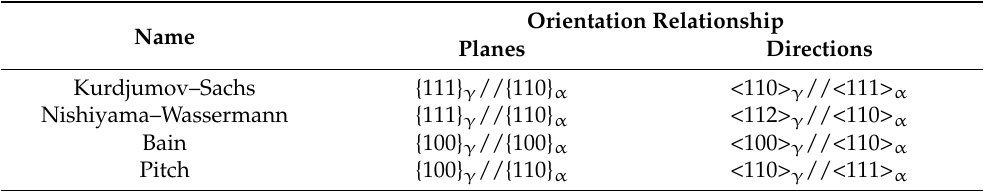
Figure 6. Ferrite variant analysis: ( a ) reconstruction of prior austenite grains; ( b – c ) distribution of deviation angles from K–S, N–W, Bain, and Pitch OR models; ( d ) a prior austenite grain containing ferrite with complex interconnecting structure; ( e ) corresponding point-to-point misorientation angle distribution along the red arrow in ( d ); ( f ) K–S ORs simulated from experimental {001} bcc pole figure of the prior austenite grain in ( d ); ( g ) {001} bcc pole figure of the prior austenite grain in ( d ); ( h ) a prior austenite grain containing variant pairs; ( i ) corresponding point-to-point misorientation angle distribution along the red arrow in ( h ); ( j ) K–S ORs simulated from experimental {001} bcc pole figure of the prior austenite grain in ( h ); ( k ) {001} bcc pole figure of the prior austenite grain in ( h ). Table 2. Fcc-to-bcc orientation relationships reported in literature.